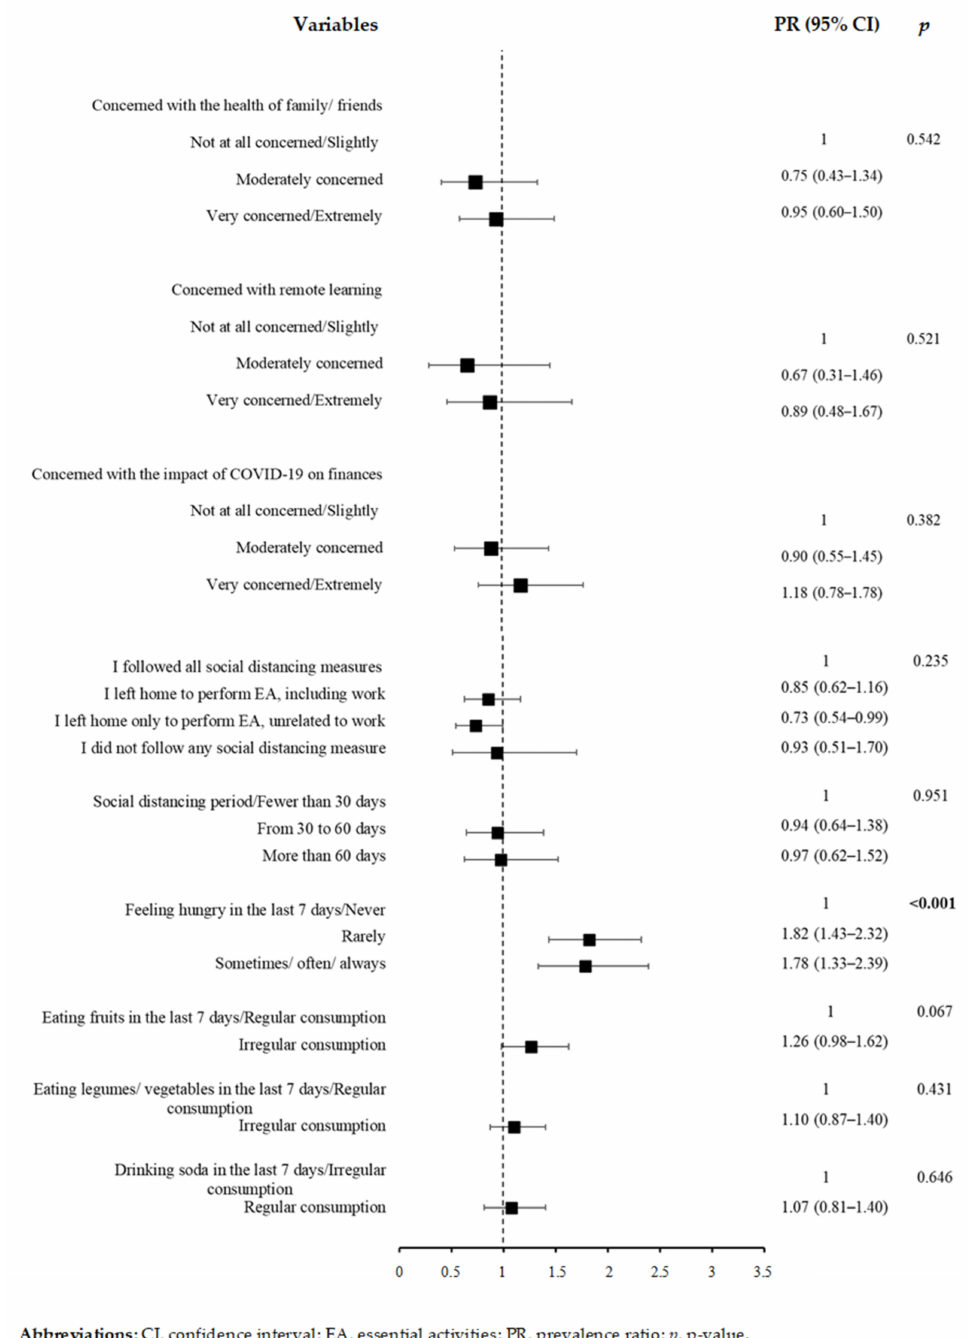
Figure 2. Poisson regression results for depressive symptoms and variables related to COVID-19 and eating habits ( n =